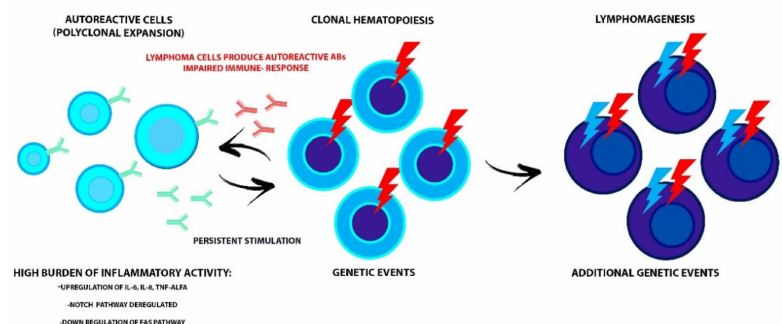
Figure 1. The interdependent relationship between AID and malignant clone evolution. The high burden of inflammatory activity could prepare for the acquisition of genetic events in HSC and progression to lymphoid malignancy. Conversely, the impaired immune-response that a ff ects the lymphoproliferative disorders and the production of autoreactive antibodies by lymphoma cells leads to AID onset. Alterations of the NOTCH and FAS pathways, involved in the maturation and survival process of lymphocytes, could trigger both diseases. AID, autoimmune disease; HSC, hematopoietic stem cells; TNF-ALFA, tumor necrosis